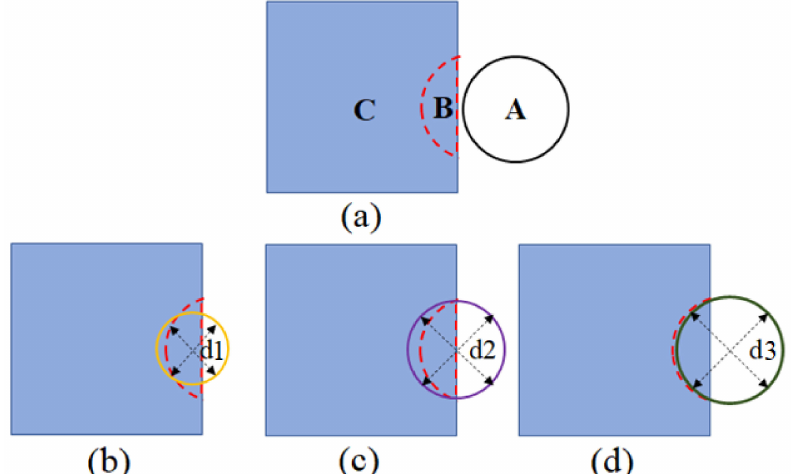
Figure 8. Edge pellet circle fitting. ( a ) Schematic diagram of the intersection and merging ratio of the edge pellets. ( b ) Least squares fitting results (with edge contours). ( c ) Circumscribed circle fitting results. ( d ) Least squares fitting results (without edge